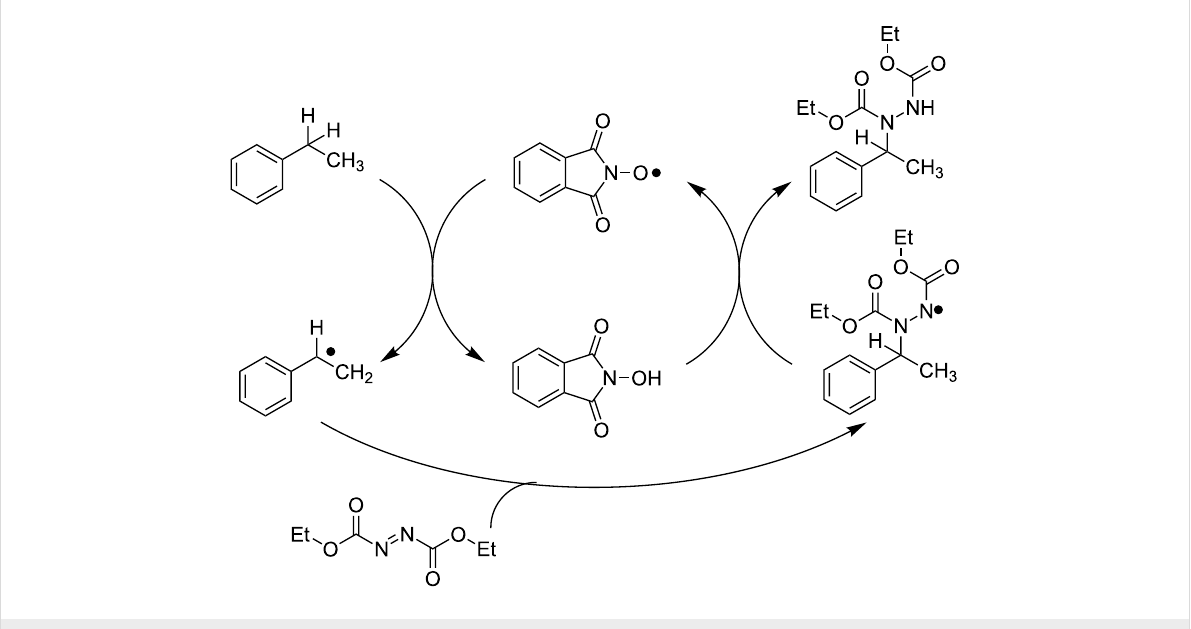
Scheme 27: Synthesis of hydrazine